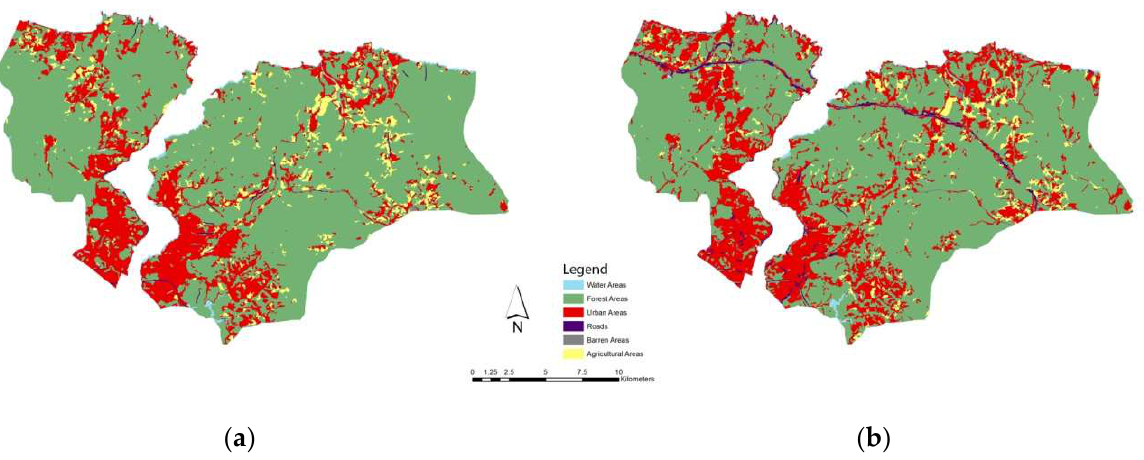
Figure 3. ( a ) Classification result for 2009, ( b ) classification result for 2019.